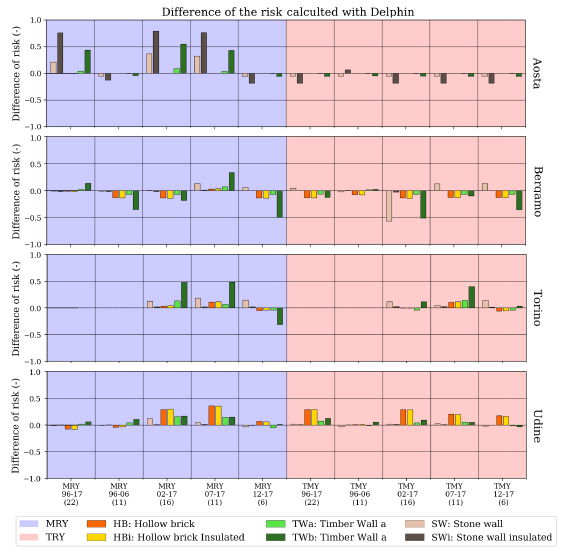
Figure 9. Evaluation of the representative years in terms of difference of moisture accumulation risk calculated with DELPHIN 6 for the four considered stations. The differences of risk are calculated between the representative years risk and the full multi-year record result. The background is blue for the Moisture Representative Years (MRY) and red for the Typical Meteorological Years